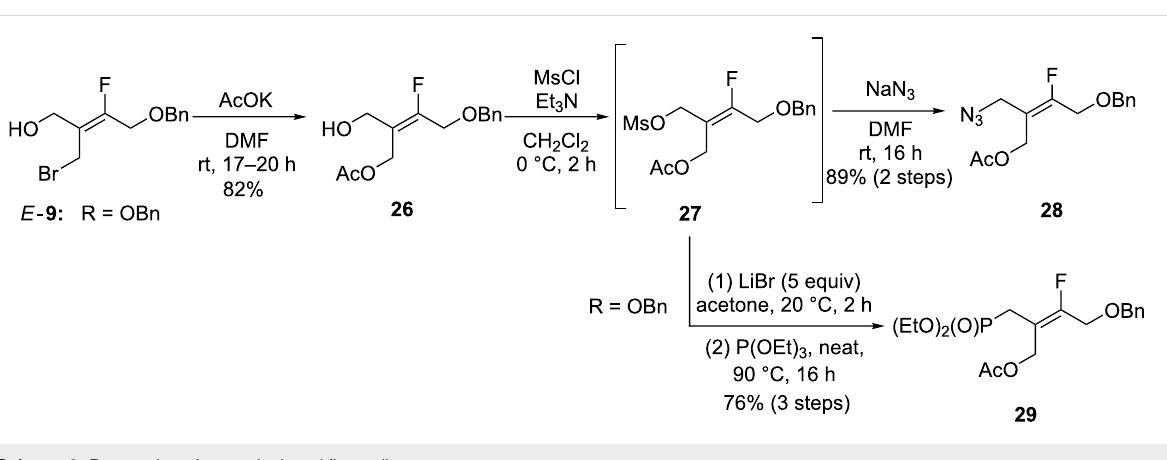
Scheme 9: Preparation of tetrasubstituted